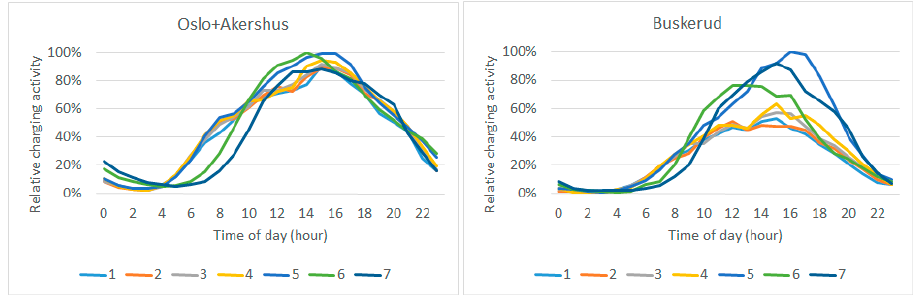
Figure 9. Percentage deviation in total minutes (all users) fast charged in network of operator 1 ( top ) and operator 2 ( bottom ) compared to minutes charged on Mondays (equal 0%) for each County. 2017. Source: Dataset 1, dataset 2 and own